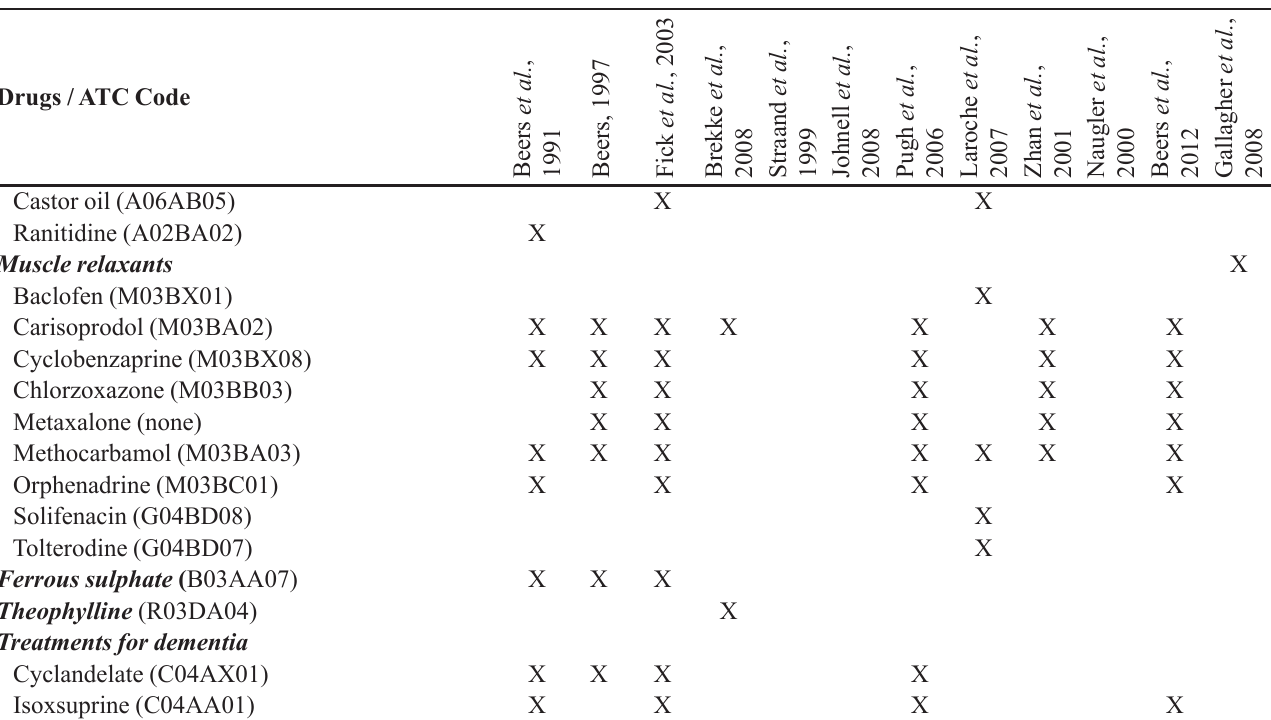
TABLE I - List of potentially inappropriate medications (PIM) for the elderly that should be avoided irrespective of diagnosis or clinical condition, according to the methods identified in PAHO (available in: http://regional.bvsalud.org/php/index.php), Lilacs and Pubmed databases, during the period between February and March 2010 (n=12) (cont.)